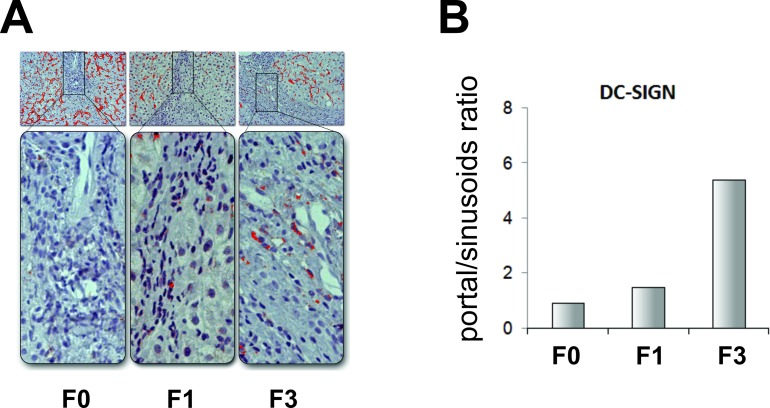
Immunohistochemical analysis of DC-SIGN+ mononuclear cells in liver biopsy specimens from patients in different stages of fibrosis (F0, F1, F3).(A) Liver biopsy specimens were stained for DC-SIGN, photographed, and images were processed using ImageJ software (upper rectangles); higher magnification of portal spaces is presented in lower rectangles. (B) The number of individual DC-SIGN+ mononuclear cells is presented as portal/sinusoids ratio (percentage of stained area in portal spaces and sinusoids).